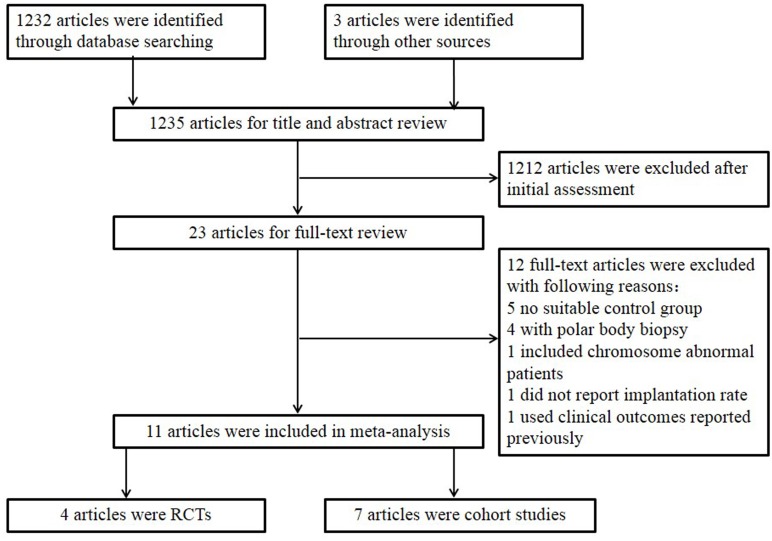
Flow chart of search and selection strategy.